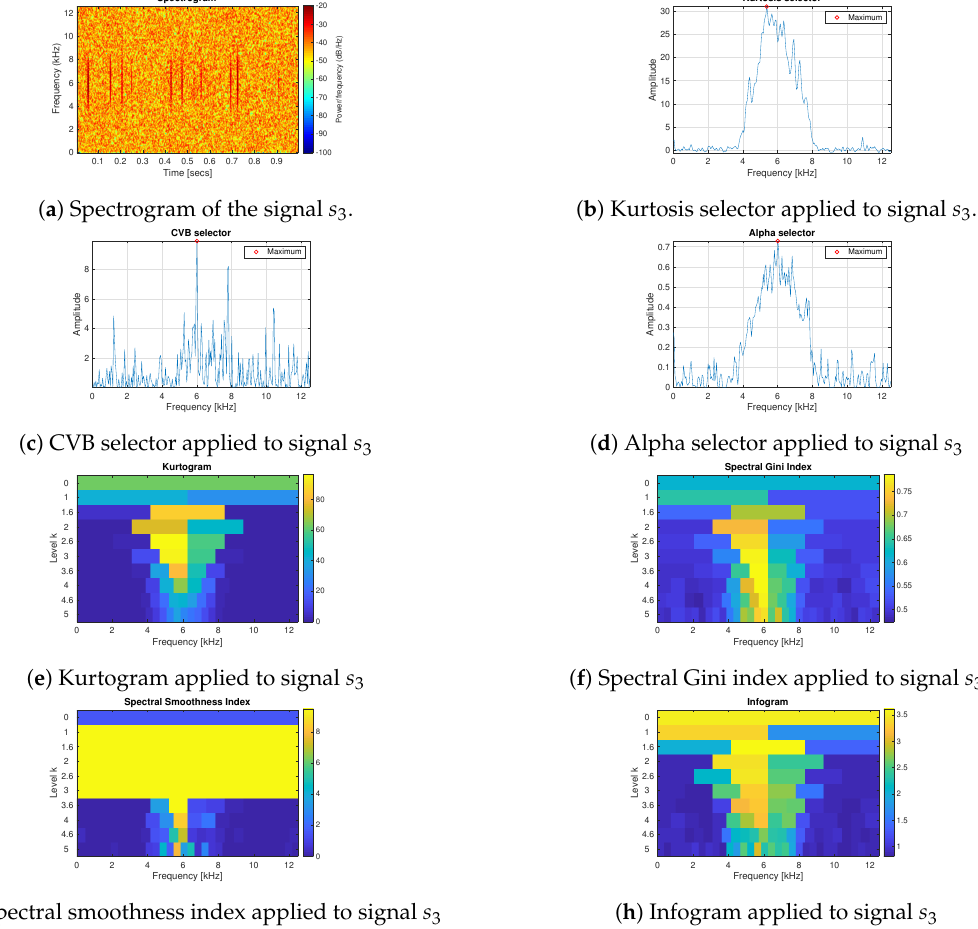
Figure 4. Results of the informative frequency band selection for 7 different methods for the signal s 3